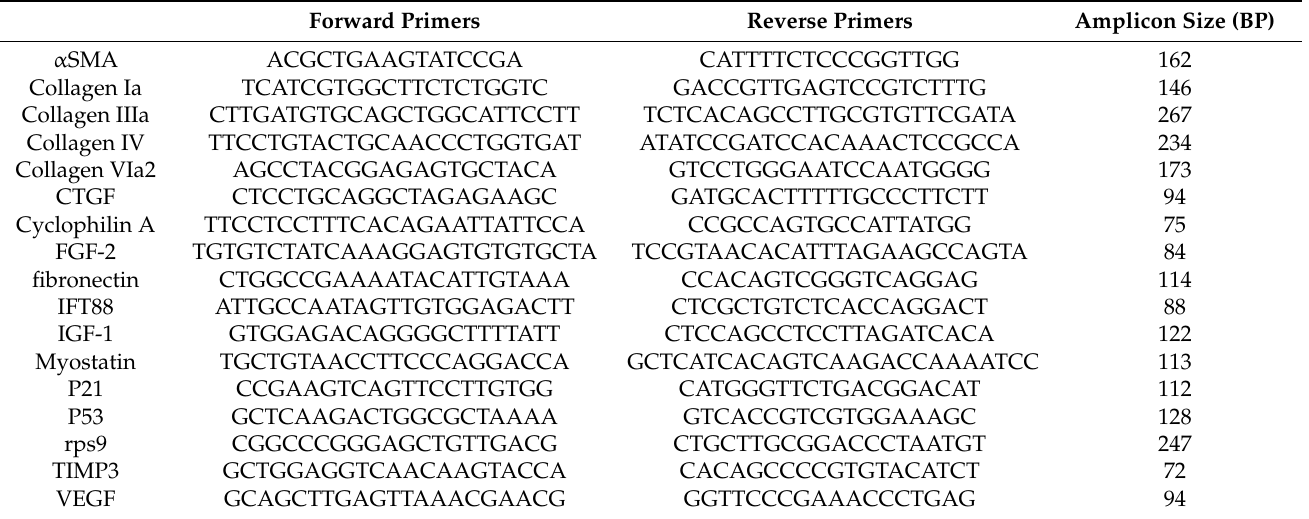
Table 2. Real-time qPCR